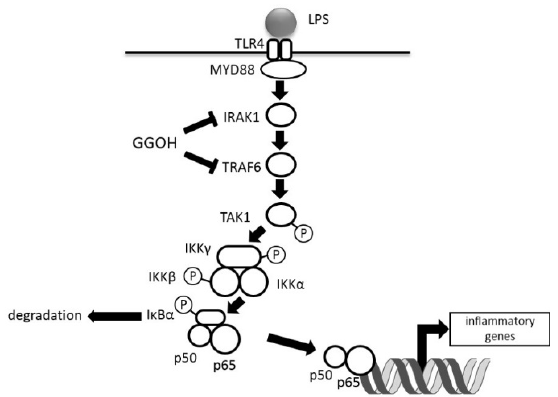
Figure 5. Schematic diagram of GGOH effects on LPS-stimulated NFκB activation. T arrows show the suppression of the expression levels.